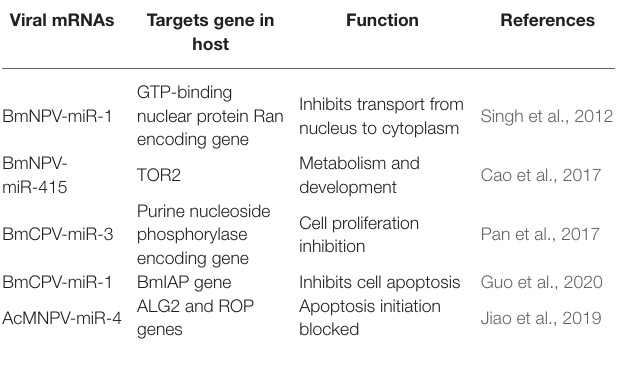
TABLE 3 | Viral mRNAs exploit the host